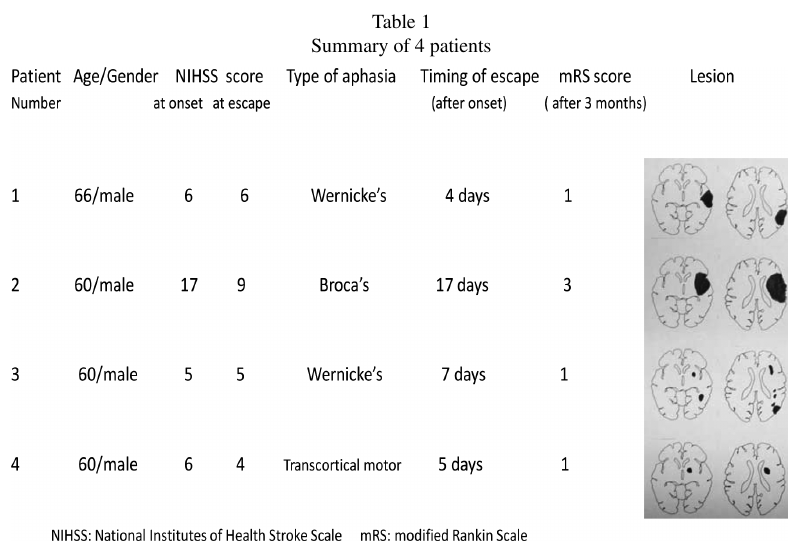
Table 1 Summary of 4